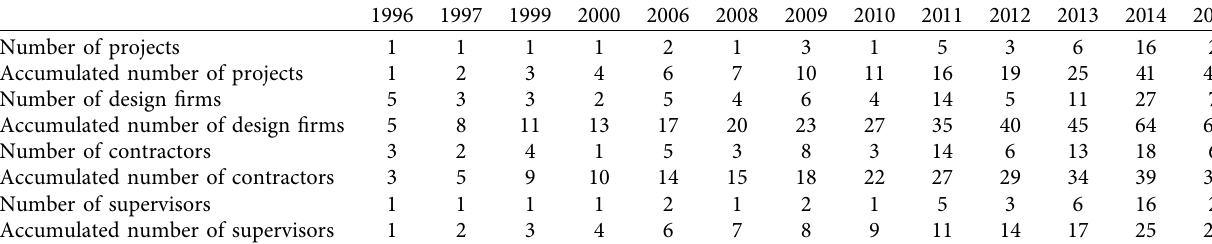
Table 2: Statistics of the skyscraper case study.